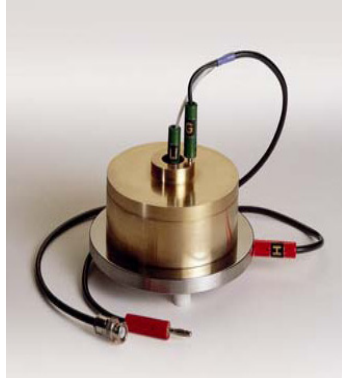
Fig. 3. (Color online) Solid test cell.